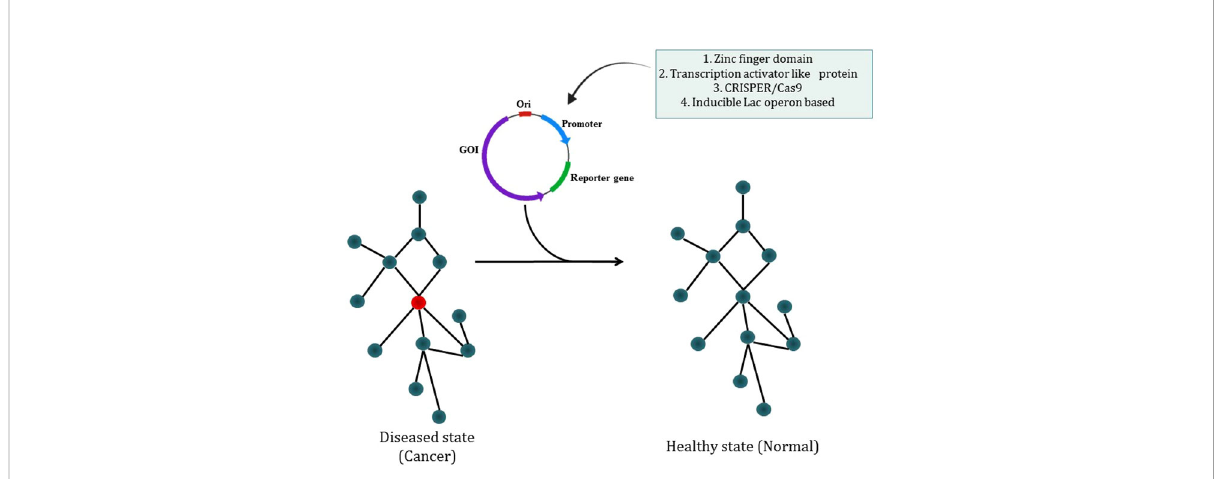
FIGURE 7 Synthetic biology modulating diseased state into a healthy state through different types of synthetic